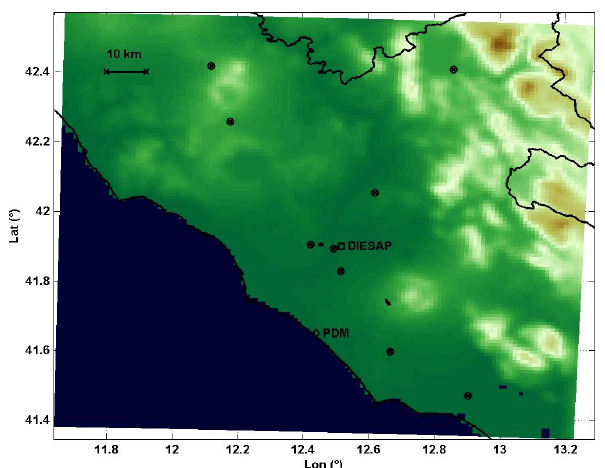
Fig. 1. The area interested by the METAWAVE WVIOP. The eleva- tion of the high-resolution inner MM5 domain is mapped in colors (from 0 to 1871m above sea level). Crossed circles indicate the lo- cation of GPS receivers. MWR and PRS were located at DIESAP (square), while ORS were launched at PDM